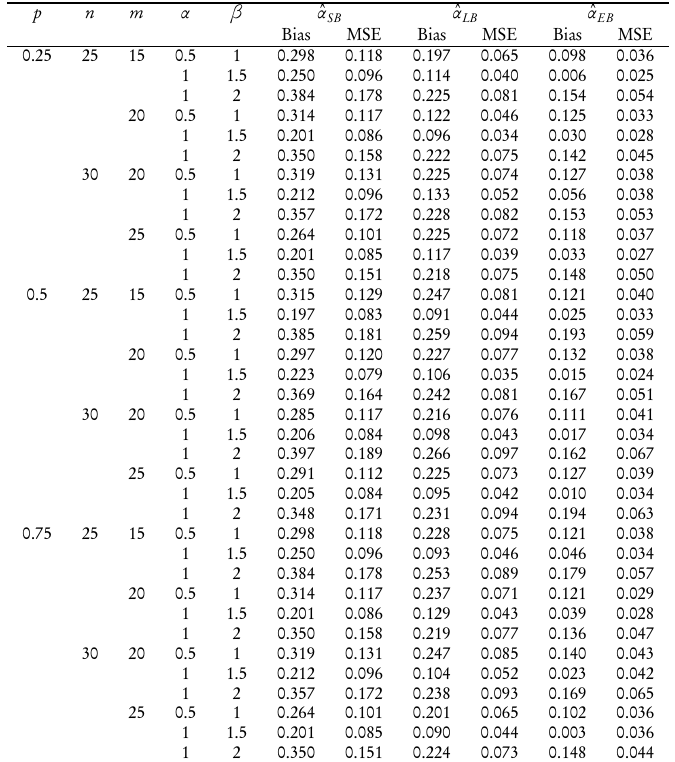
for different choices n, m, α , β and p = 0.25, 0.5 and EB